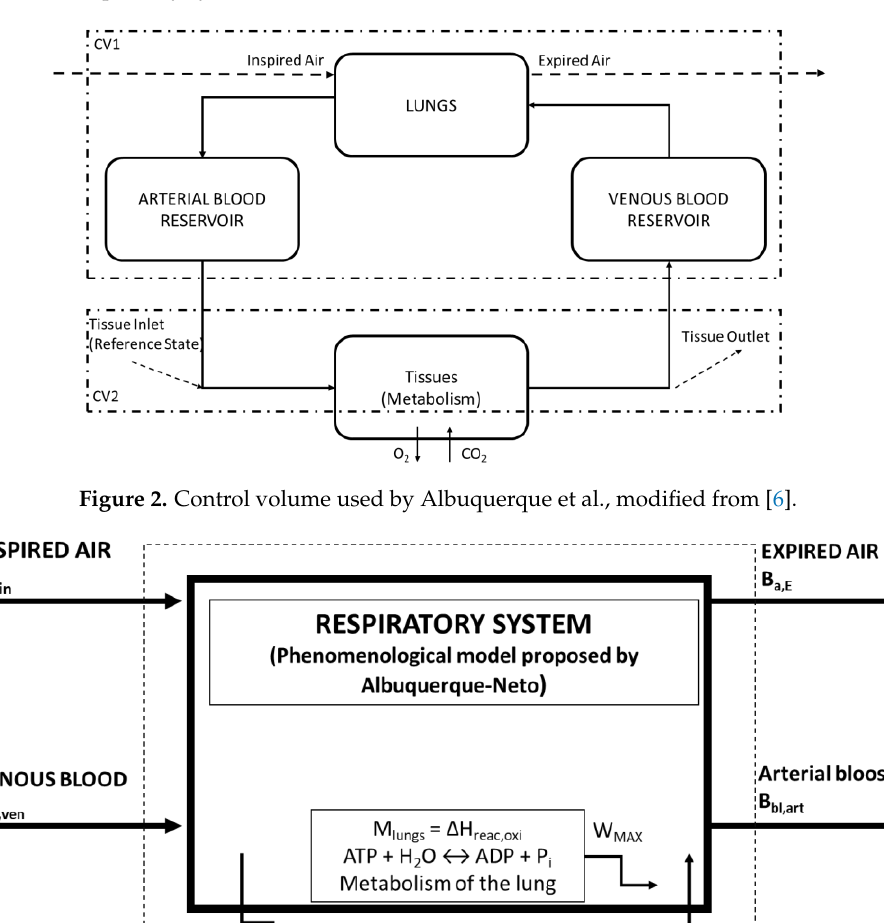
Figure 1. Human body schematic representation with circulatory and respiratory systems, modified from [8]. The respiratory system was obtained from [11].